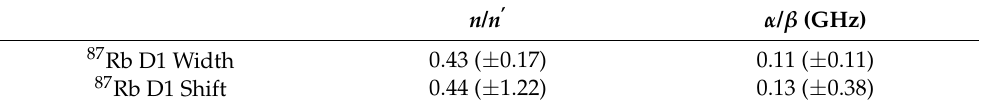
Table 2. The fits to the measured line widths and frequency shifts of N 2 , as a function of